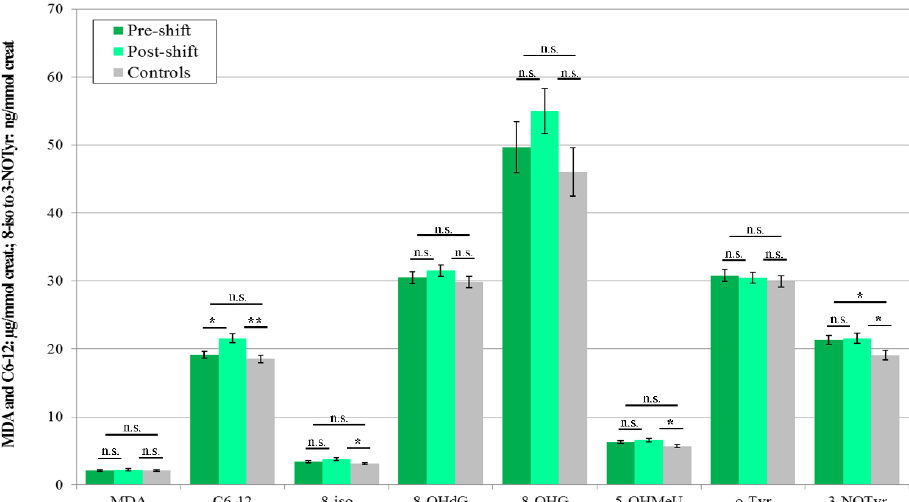
Figure 5. Mean and standard deviation of the levels of eight oxidative stress markers in the urine of 20 workers (shift = machining) and 20 control subjects (morning) in 2017, * p < 0.05, ** p < 0.01, n.s. = not significantly different, creat. = creatinine, MDA = malondialdehyde, C6-12 = aldehydes C6-C12, 8-iso = 8- iso -prostaglandin F2α (8-isoprostane), 8-OHdG = 8-hydroxy-2-deoxyguanosine, 8-OHG = 8-hydroxyguanosine, 5-OHMeU = 5-hydroxymethyl uracil, o-Tyr = o -tyrosine, 3-NOTyr = 3-nitrotyrosine.